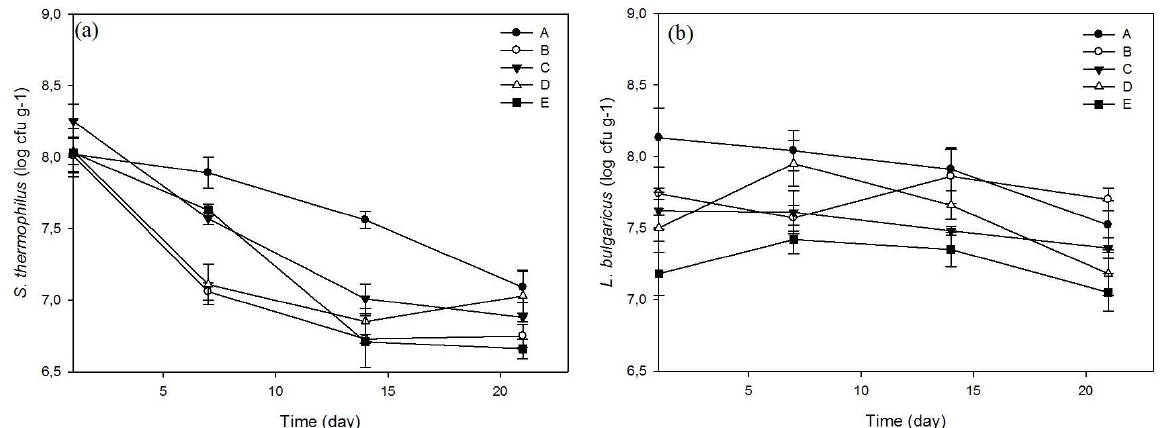
Figure 1. Growth of S. thermophilus (a) and L. delbrueckii subsp. bulgaricus (b) during storage of yoghurt-like products produced with cow milk and hazelnut beverage during storage at 4